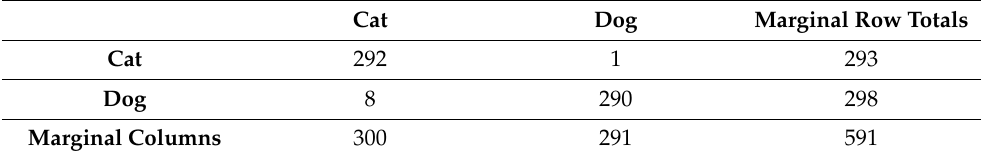
Table 7. Confusion matrix of ResNet 152 and VGG 19 model.